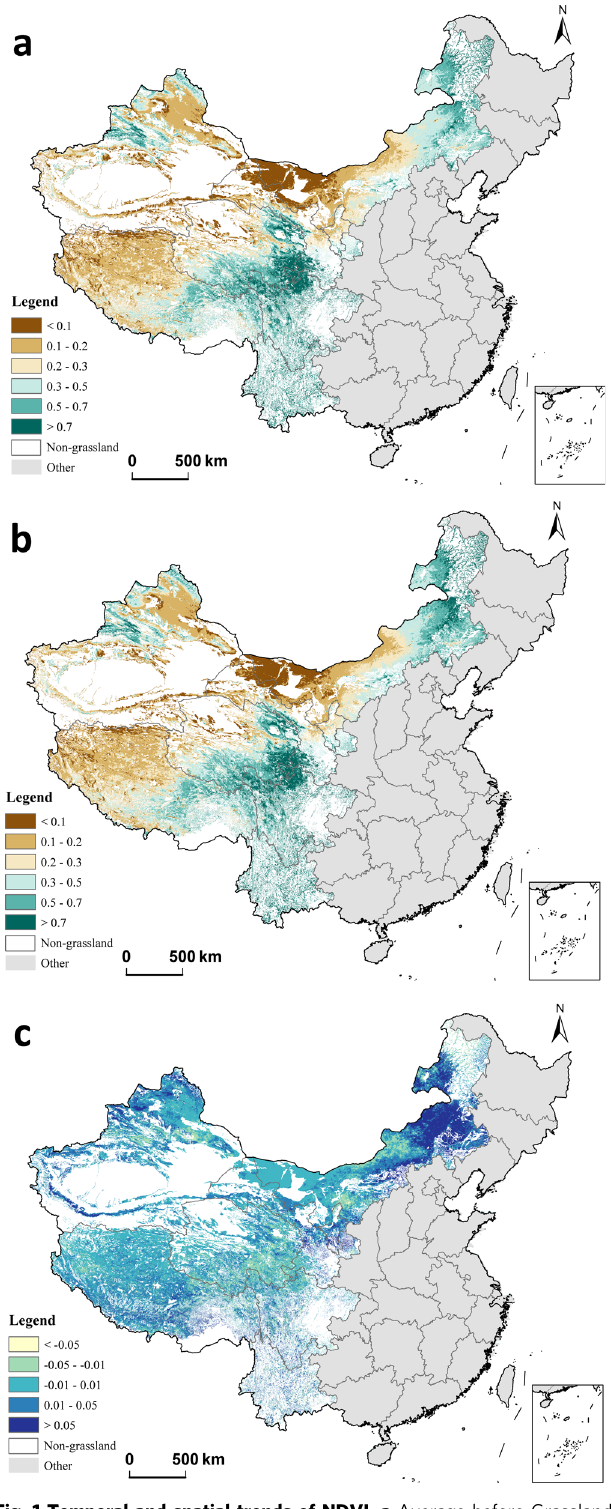
Fig. 1 Temporal and spatial trends of NDVI. a Average before Grassland Ecological Compensation Program (GECP) implementation (2006 − 2010); b average NDVI after GECP implementation (2011-2015); c difference in NDVI before and after GECP implementation. NDVI stands for the Normalized Difference Vegetation Index, which is a measure for grassland quality. It was constructed based on infrared and near-infrared channel remote sensing images and has been widely used as an indicator of vegetation